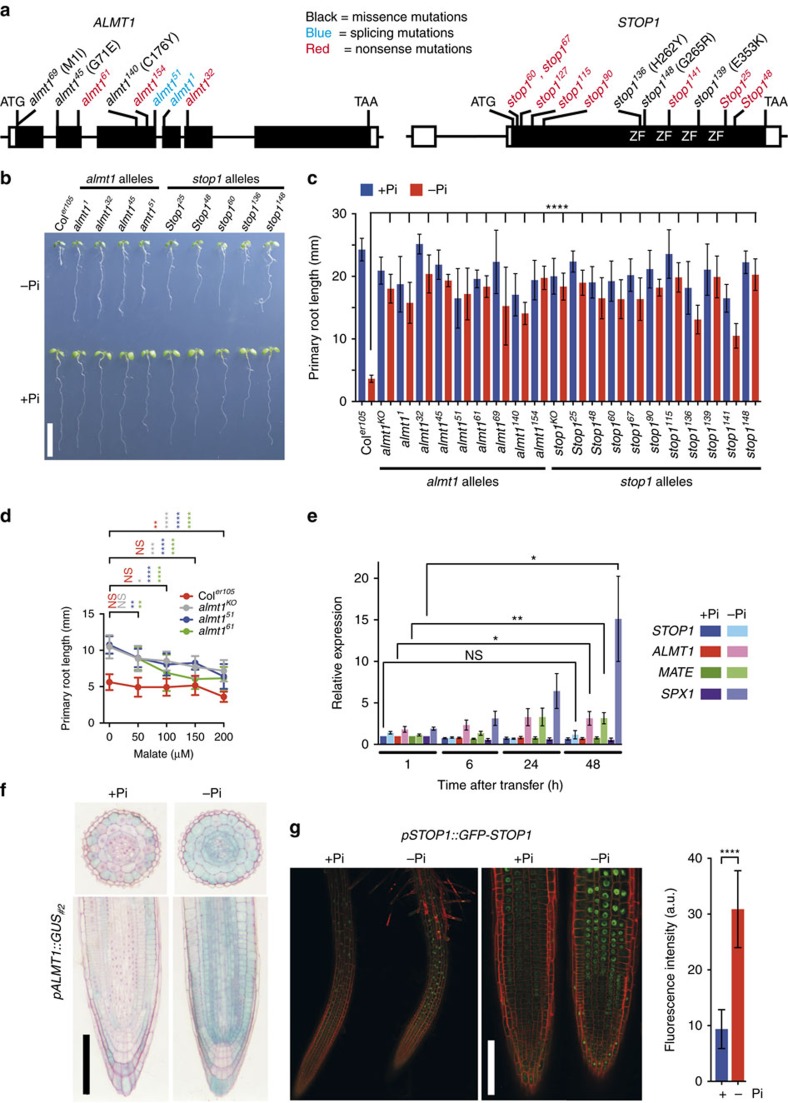
Phenotype of almt1 and stop1 mutants and expression of ALMT1.(a) Position and nature of the almt1 and stop1 mutations. (b) Appearance of representative WT and mutant seedlings after germination and growth for 6 days on +Pi or −Pi medium. (c) Primary root length of WT (Coler105) and mutant seedlings grown for 6 days in +Pi or −Pi conditions. Mean±s.d., n=9–14 seedlings per line and condition; unpaired two-tailed t-test; ****P<0.0001). (d) Malate complementation. WT and almt1 seedlings grown under +Pi for 2 days were transferred for 6 days to −Pi medium with or without the indicated concentrations of malate (mean±s.d., n=7–14 seedlings per condition; two-way ANOVA, ****P<0.0001; ***P<0.001; **P<0.01; *P<0.05; NS, not significant). (e) Gene expression analysis. WT seedlings grown under +Pi for 5 days were transferred to +Pi or −Pi medium for 1–48 h, total root RNA was extracted and expression of the indicated genes analysed by qRT–PCR. SPX1 was used as a positive marker for the −Pi stress. Relative expression levels are normalized to that of the +Pi at 1 h (mean±s.e.m., n=6 independent experiments; unpaired two-tailed t-test; **P<0.01; *P<0.05; NS, not significant). (f) Pattern of ALMT1 expression in primary root tip. Transverse (top) and longitudinal (bottom) sections of the root tip of pALMT1::GUS (WT). Seedlings were grown 5 days under +Pi and transferred to +Pi or −Pi medium for 48 h prior to GUS staining. (g) GFP-fluorescence of GFP-STOP1 in root tips. Four-day-old stop1KO;pSTOP1::GFP-STOP1 (# B10A) seedlings grown under +Pi were transferred to +Pi or −Pi plates for 24 h, and GFP-fluorescence was visualized by confocal microscopy. Left panel: the two roots were mounted side by side on the same microscope slide (× 10 objective). Middle panel: magnification of the root tips (× 20 objective). See also Supplementary Fig. 6c for additional lines. Right panel: intensity of the GFP-fluorescence (a.u., arbitrary units) in nuclei of the root tip (mean±s.d., n=54 and 43 nuclei in + Pi and −Pi, respectively; unpaired two-tailed t-test; ****P<0.0001). Two (c,d,f) or three (g) independent experiments were performed with consistent results and one representative experiment is shown. Scale bars, 1 cm (b), 100 μm (f,g).